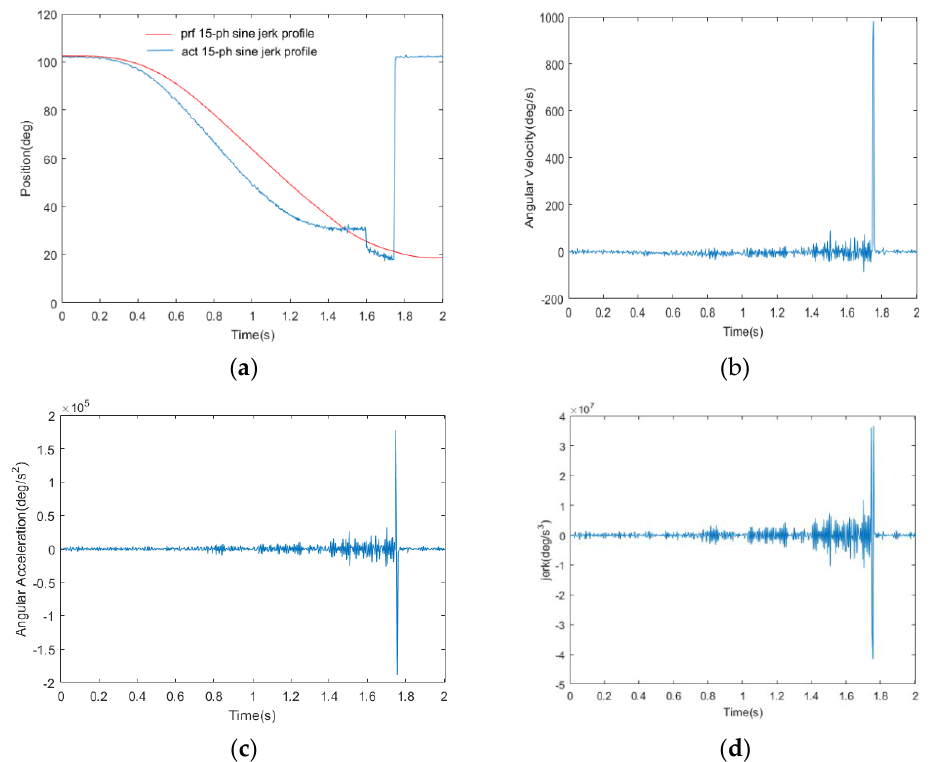
Figure 8. Simulation and experimental comparison curves of 15-phase sine jerk motion profile key characteristic in Joint 1: ( a ) angular displacement curve, ( b ) angular velocity curve, ( c ) angular acceleration curve, and ( d ) angular acceleration rate.